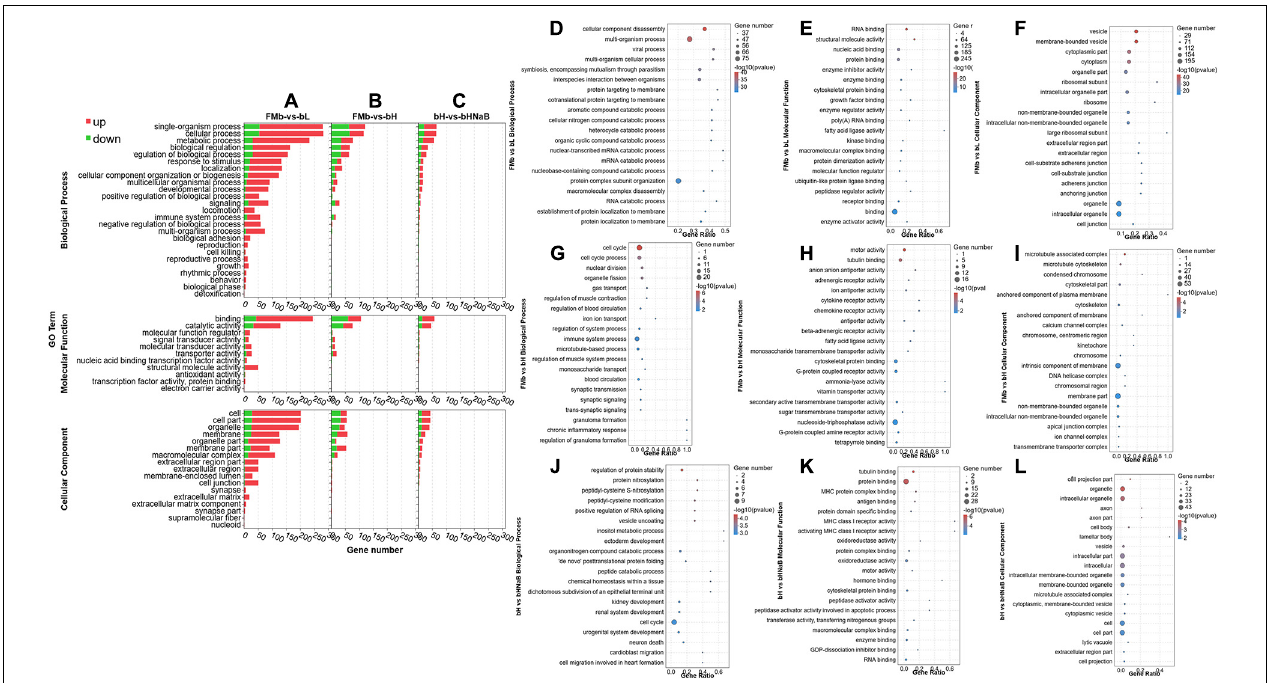
FIGURE 3 | GO classification and enrichment analysis of the DEGs in the distal intestine of hybrid grouper. GO terms of FMb vs. bL, FMb vs. bH and bH vs. bHNaB. Distribution of the top 20 (level-2) GO terms significantly enriched in the categories of biological process, molecular function, and cellular component in FMb vs. bL (A,D–F) , FMb vs. bH (B,G–I) , and bH vs. bHNaB (C,J–L)